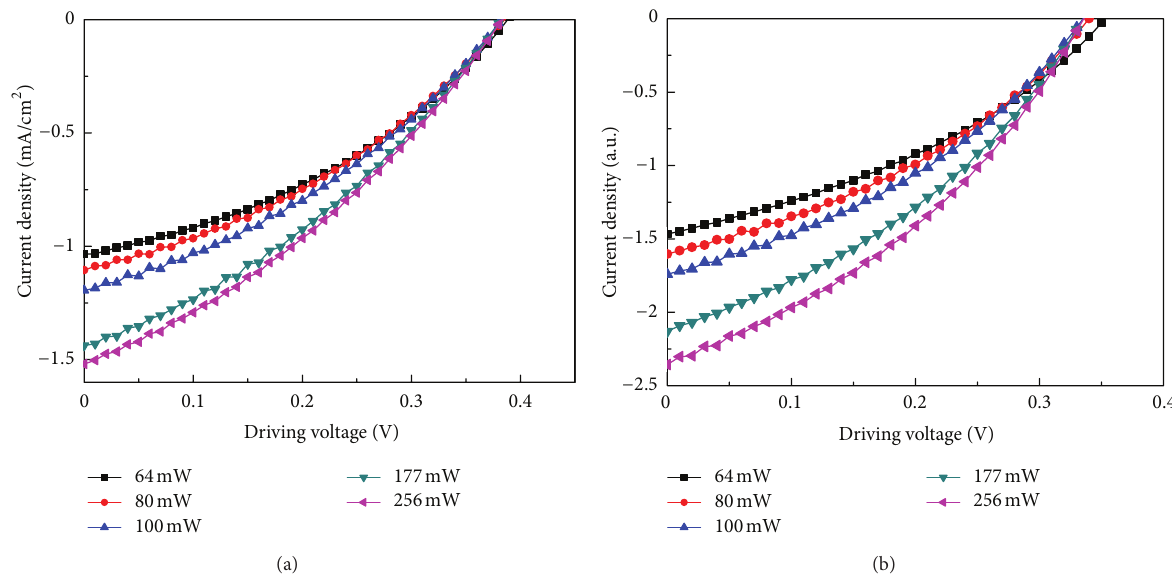
Figure 4: J-V characteristics of two kinds of OPVs under different illumination intensities, (a) PbPc films prepared under normal conditions; (b) PbPc films prepared by GLAD.